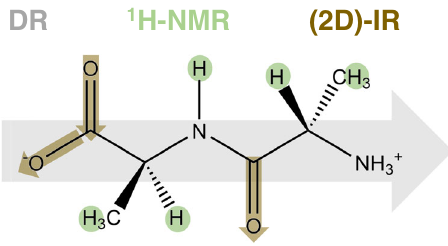
Fig. 1 Schematic illustration of the combined experimental approach to study ion-speci fi c effects on 2Ala. Dielectric relaxation spectroscopy probes the dynamics of 2Ala ’ s electrical dipole (gray arrow), 1 H-NMR spectroscopy the chemical environment of 2Ala ’ s protons (marked green), and 2D-IR detects the vibrational dynamics of the CO and anti-symmetric COO − stretching vibrations of 2Ala (marked brown).